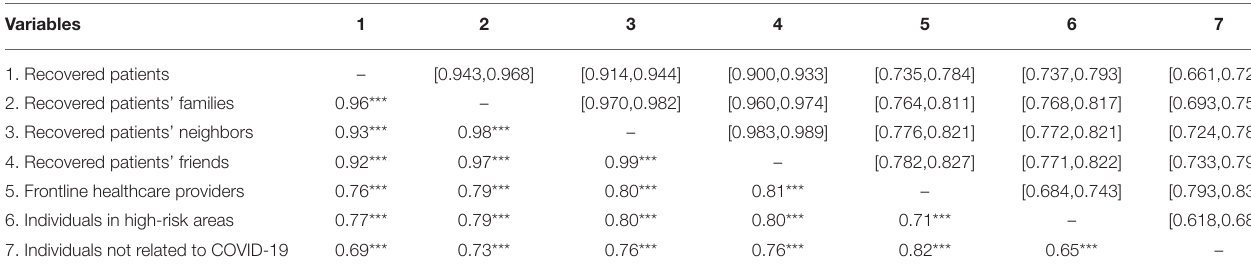
TABLE 3 | Correlations between different types of COVID-19-related stigma ( N = 1,920).